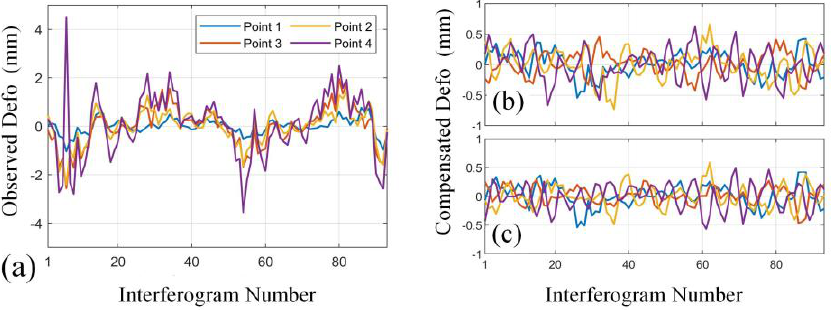
Table 3. The standard deviations of the residual phase for the four points in time series obtained by the range-related model and the 2D model (mm).